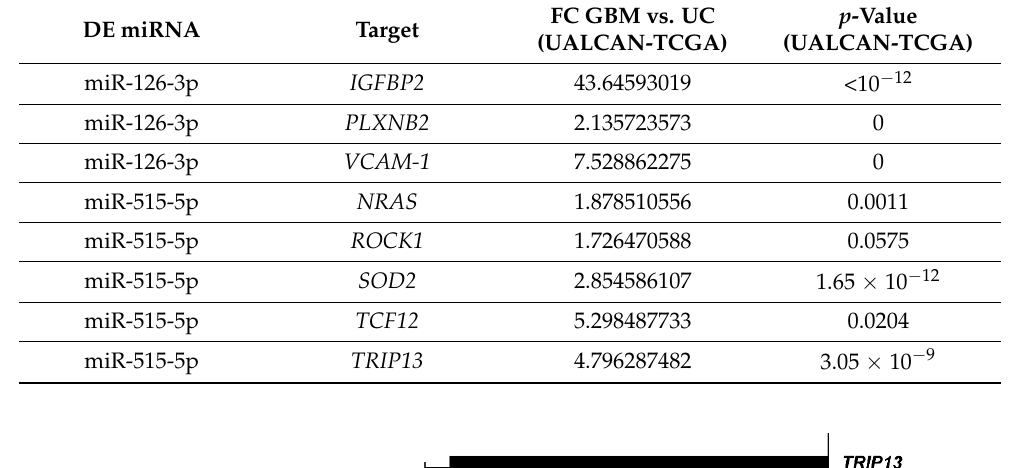
Table 2. Selected targets of miRNAs 126-3p and 515-5p. Data reported in the table have been retrieved from UALCAN database.